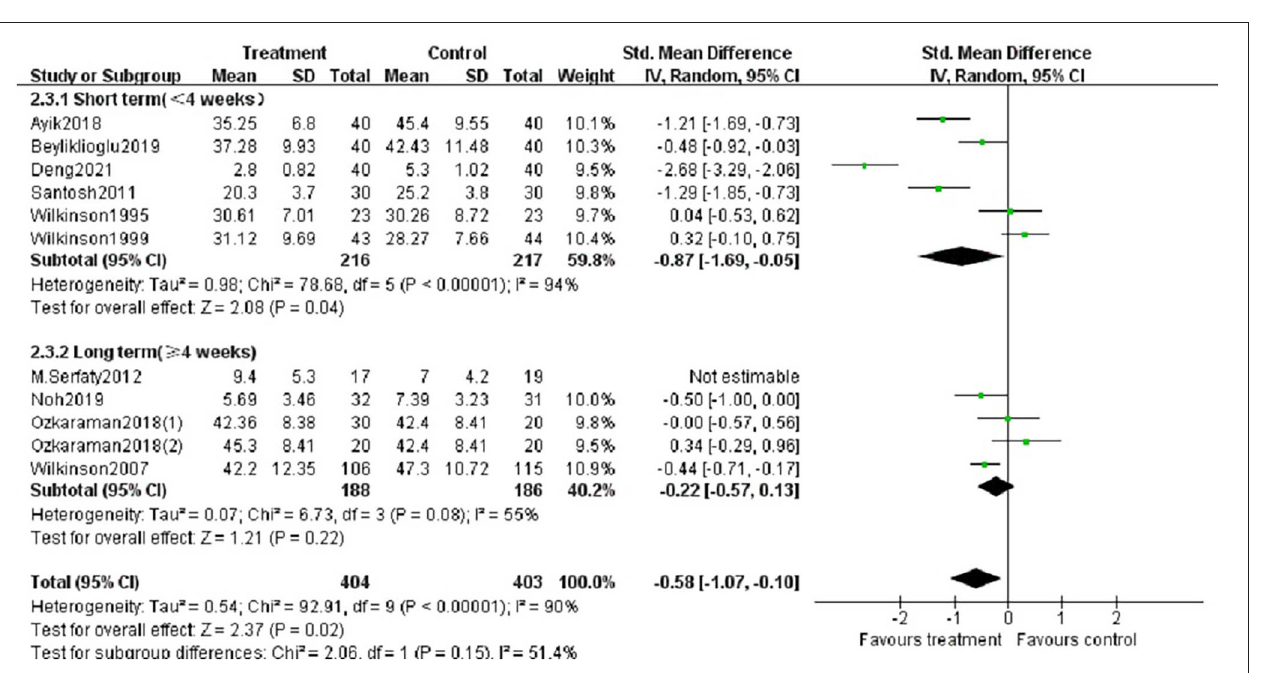
FIGURE 9 | Subgroup analysis according to the duration of aromatherapy